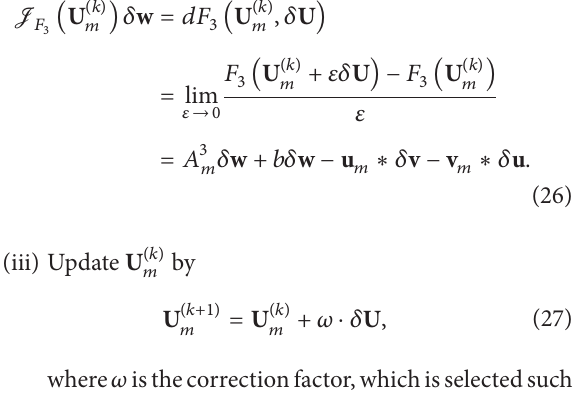
From these figures, it may be concluded that, for 𝛼 = 𝛽 = 𝛾 =